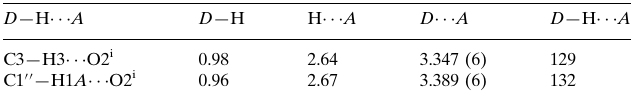
Hydrogen-bond geometry (A˚ , (cid:1)